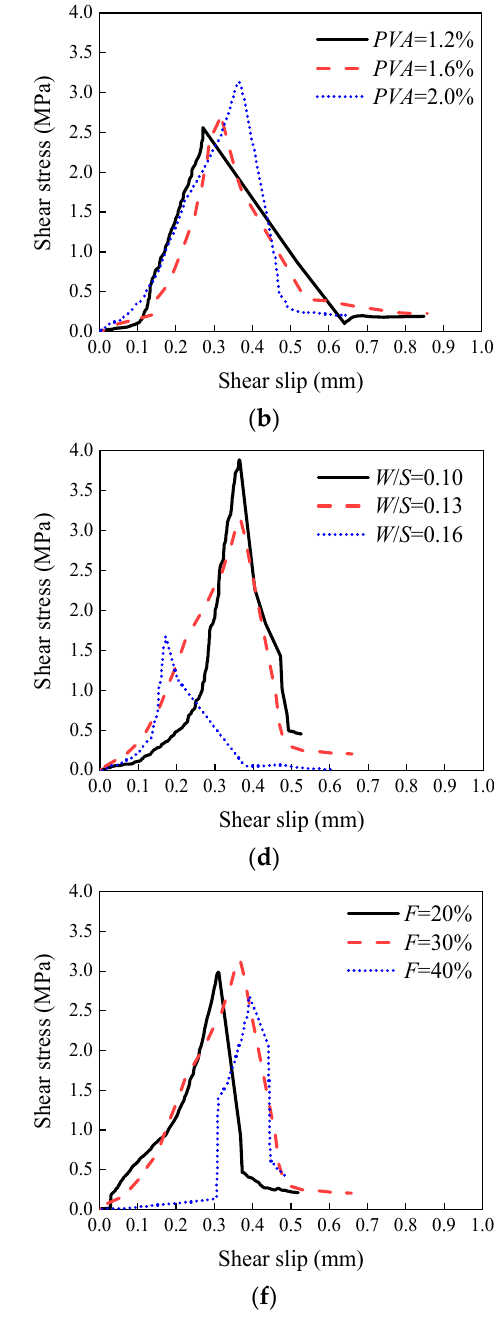
Figure 12. Bond–slip curves under different ( a ) V f ; ( b ) B ; ( c ) M / P ; ( d ) W / S ; ( e ) S / B ; ( f ) F . Based on the above results, this study chose the ultimate shear bond stress, the slip value corresponding to the ultimate shear bond stress, and the interfacial fracture energy as eigenvalues, and proposed a simplified bond–slip constitutive relationship model, as shown in Equations (3)–(7) [2].